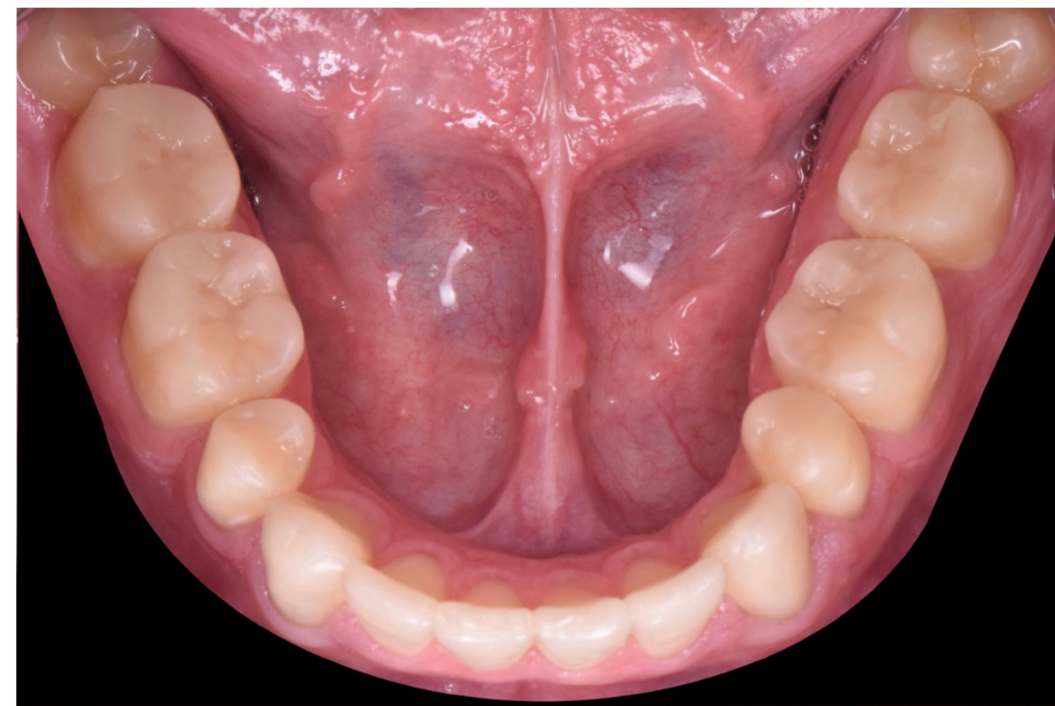
Figure 36. Final intraoral occlusal picture (lower